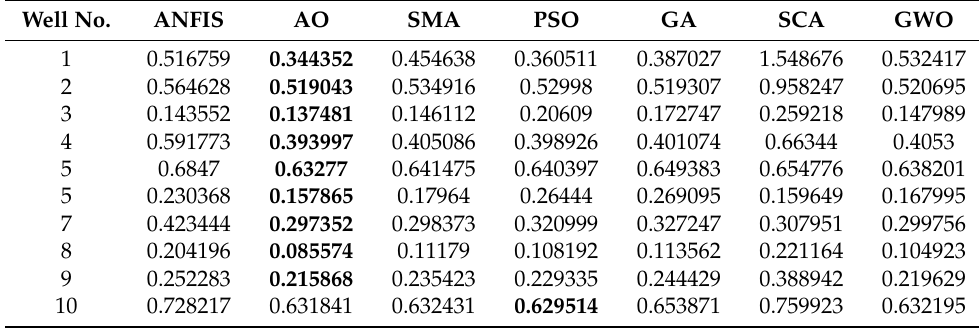
Table 4. The results of the Tahe oilfield in terms of MAE. The best values are shown in bold. Well No.